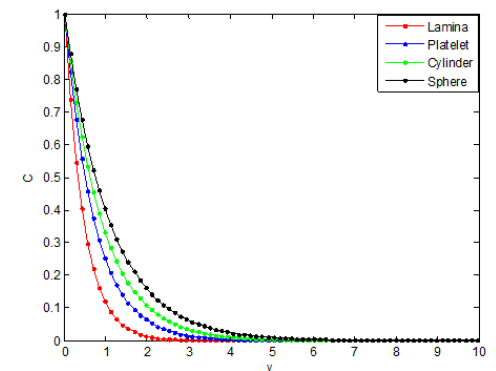
Figure 11. Effects of nanoparticle shape on concentration distribution